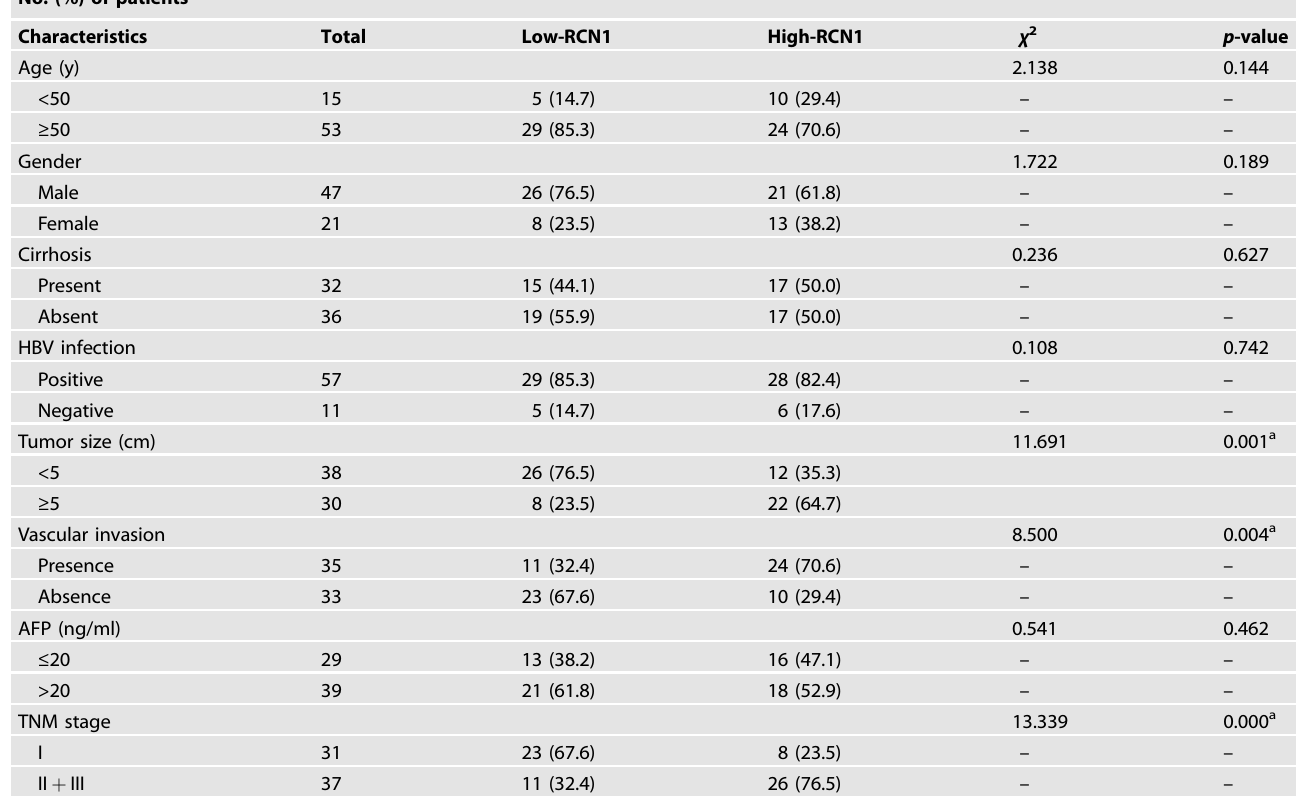
Table 2. Association between RCN1 expression and clinicopathological features in patients with HCC ( n = 68). No. (%) of